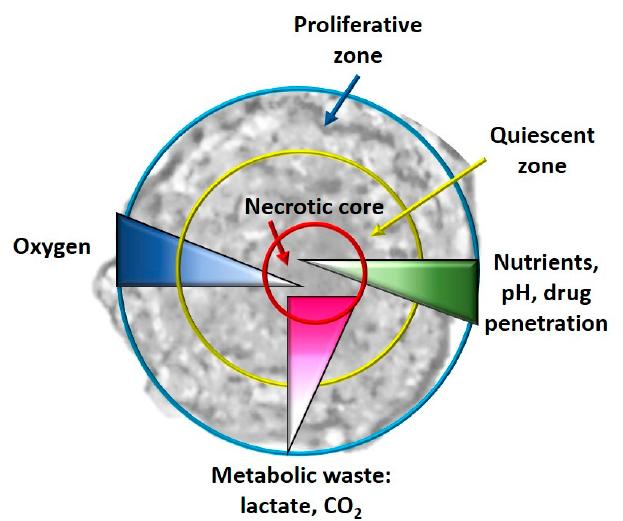
Figure 3. Graphical representation of the different zones (proliferative, quiescent and necrotic) and the different gradients (oxygen, nutrients, drug penetration and metabolic waste) in a typical spheroid.